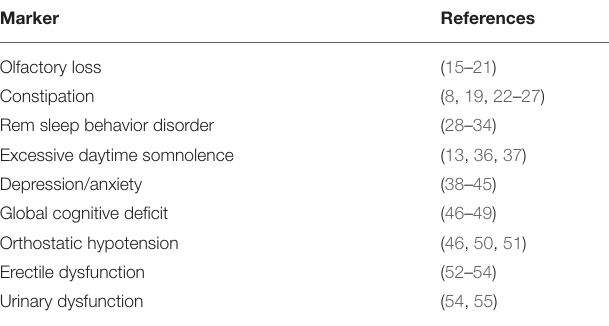
TABLE 1 | Clinical non-motor markers of prodromal Parkinson’s